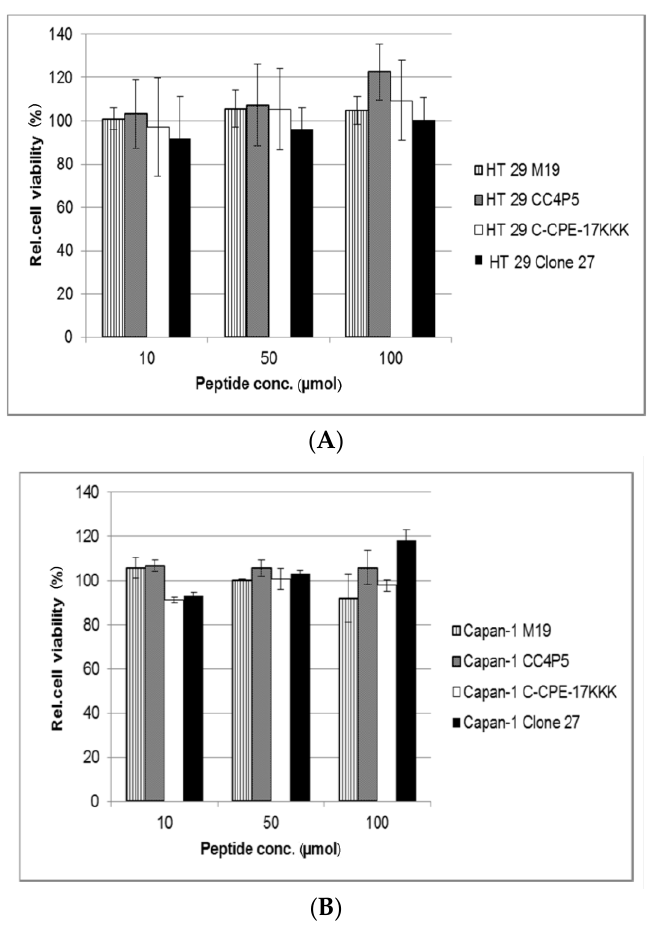
Figure 4. Cytotoxicity assay of HT-29 ( A ) and Capan-1 ( B ) cell lines. Solutions of 5-FDR-peptide conjugates (10, 50, 100 µmol·L −1 ) were incubated with the respective cells at 37 °C for 24 h.